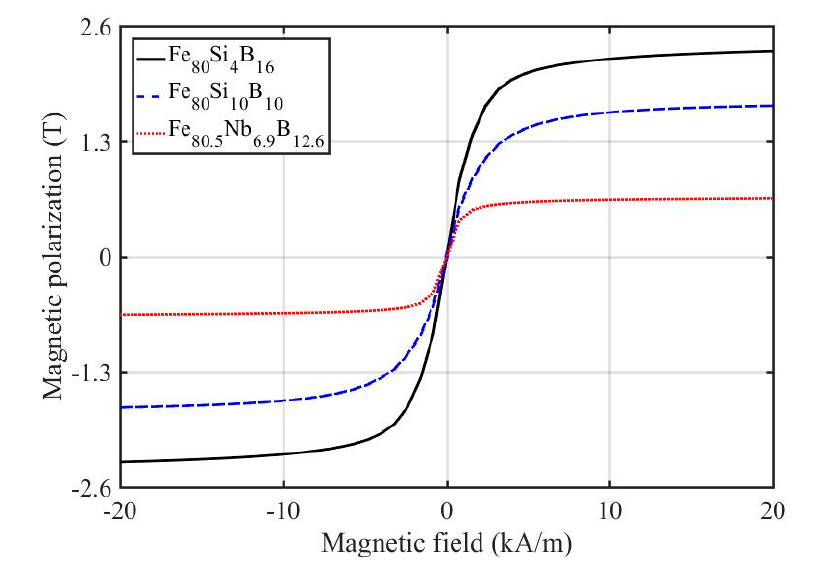
Figure 3. Bulk hysteresis loops of analyzed ribbons measured using the vibrating-sample magne- tometer.